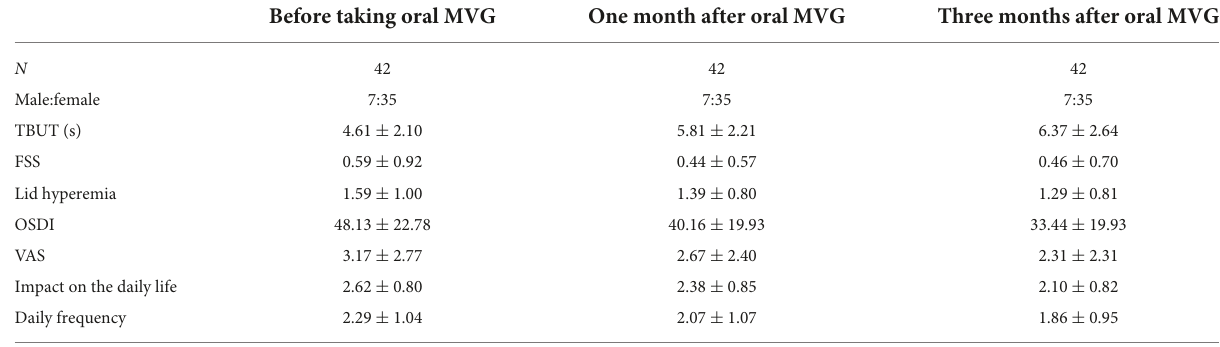
TABLE 1 Signs and general symptoms change before and after taking oral MVG.